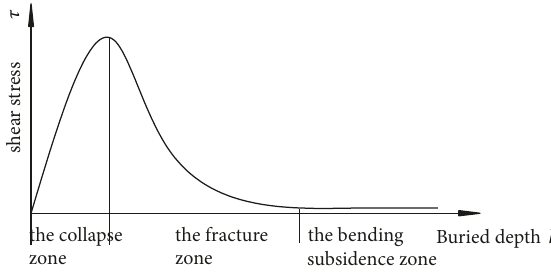
Figure 5: Diagram of “three zones” height in overlying